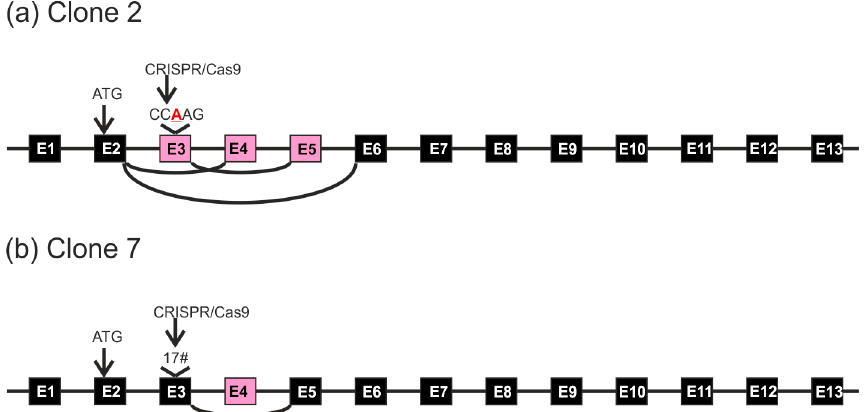
Figure 9. Observed genomic changes and corresponding alterations in mRNA sequences upon FLOT1 gene knockout. ( a ) Clone 2, and ( b ) clone 7. Exons whose splicing is altered are shown in pink.